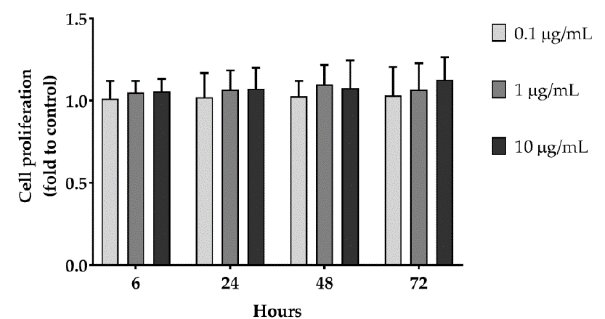
Figure 4. Cell proliferation assay. HaCaT cells were treated with increasing concentrations (0.1 to 10 μg/mL) of different extract (as indicated) or DMSO (Ctrl). The SRB absorbance at 540 nm was recorded 6, 24, 48, and 72 h after treatment. Data are expressed as mean ± SD of three independent experiments and normalized to the Ctrl value. One-way ANOVA was used for determining the statistical differences between groups.